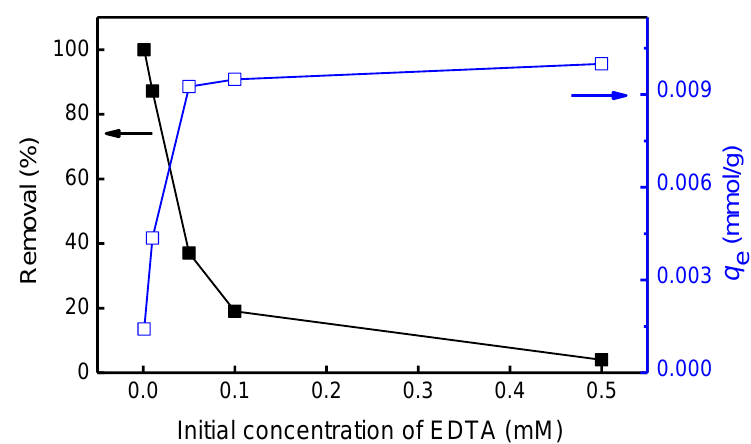
Figure 11. Changes in removal efficiency of EDTA ( ■ ) and adsorption capacity (□) of CERs in EDTA/Cs (1:1) containing different EDTA concentrations (0.001–0.5 mM). [CERs] = 2 g/L; pH = 7; adsorption time = 5 h.